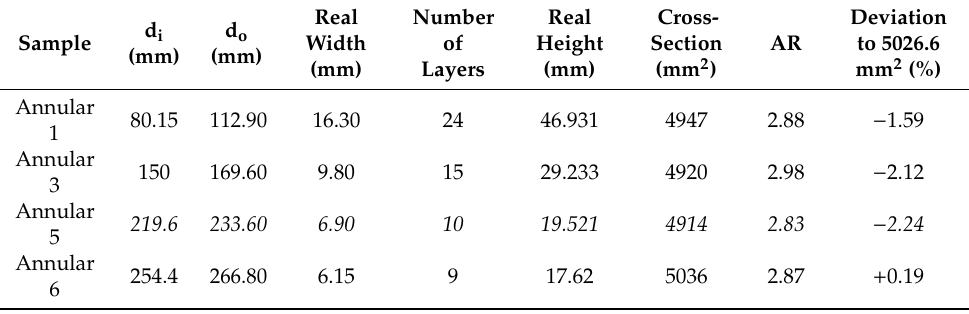
Table 4. Geometric dimensions of annular samples with an aspect ratio of approximately three. Cross-section calculated using d 0 and material width. Deviation related to 5026.6 mm 2